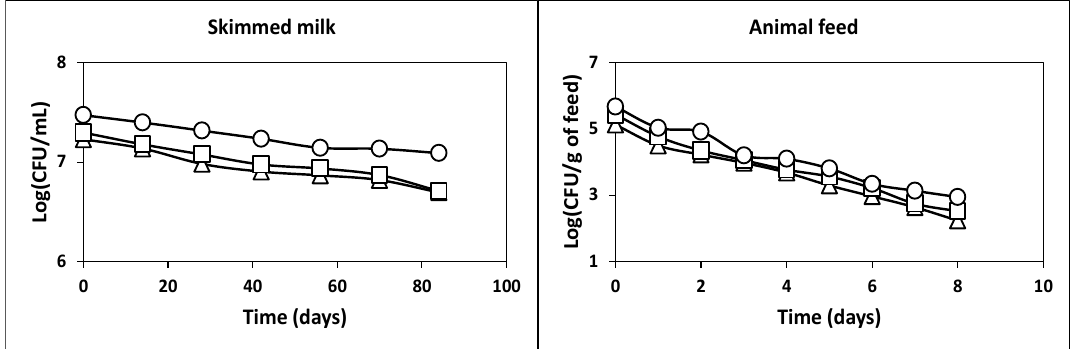
Figure 8. Survival of the populations of LAB ( circles ), AAB ( squares ) and yeasts ( triangles ) during storage at − 20 °C with skim milk ( left part) and in the commercial feed at room temperature ( right part). The experimental data represent the means of three experiments and two analytical replicates.